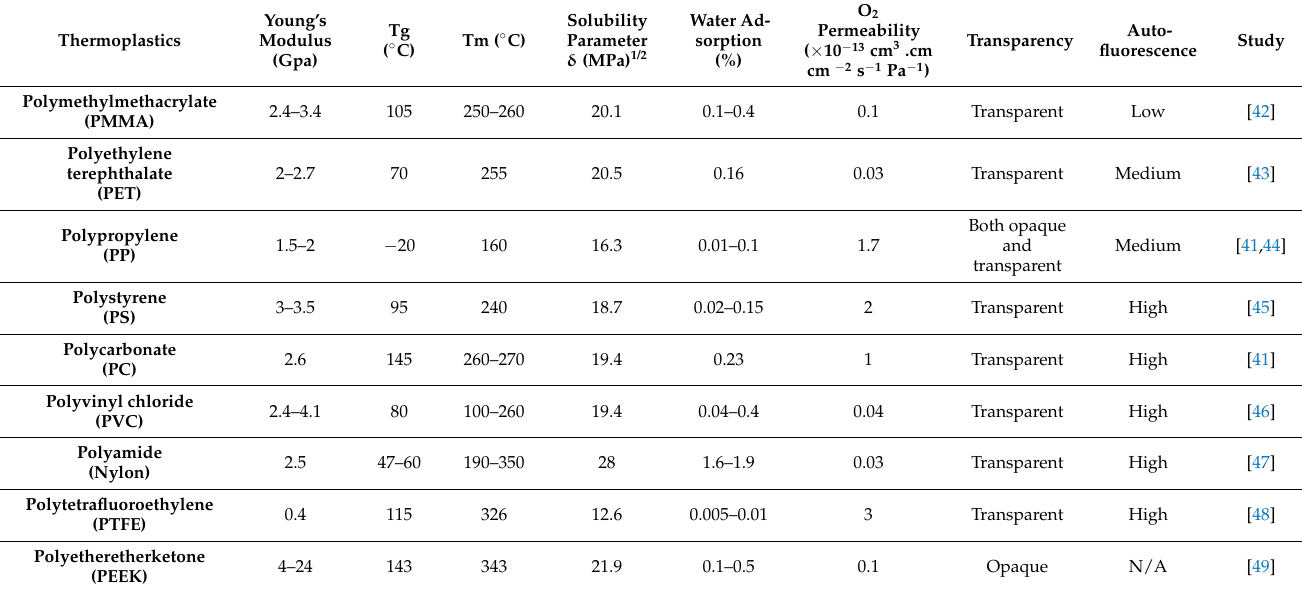
Table 1. Properties of the most used biocompatible thermoplastics in the microfluidic